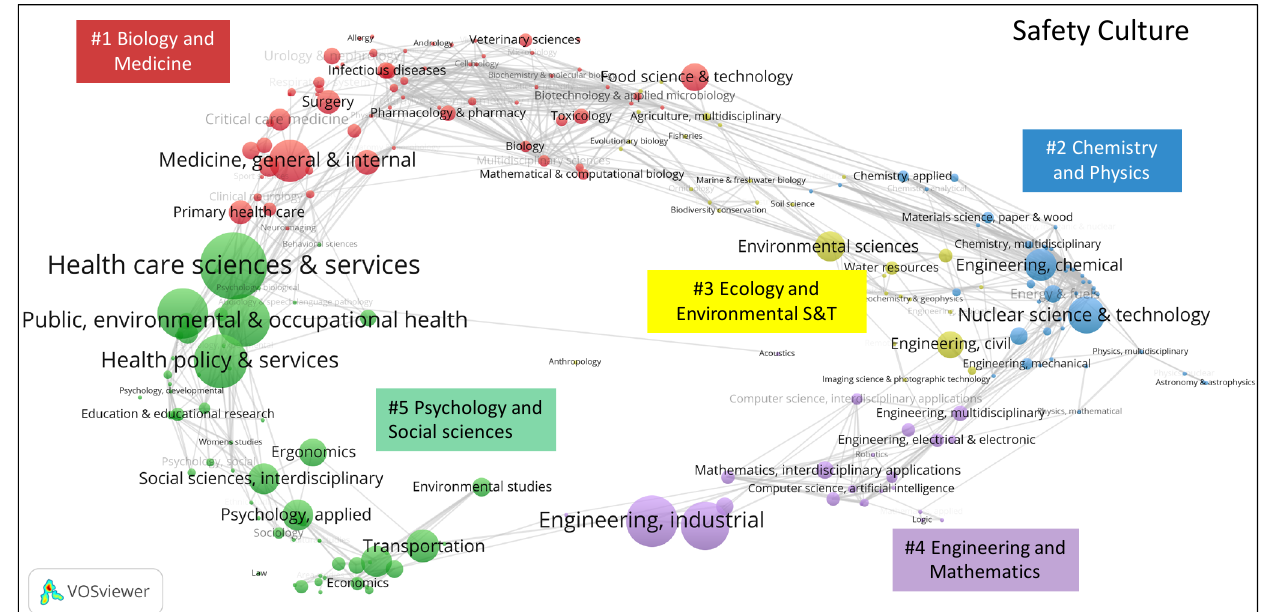
Figure 7. Location of Web of Science categories for safety culture publications in the global science overlay map (generated using the Loet Leydesdorff disciplinary overlay toolkit and visualized using VOSviewer; see Section 2.2 for references)